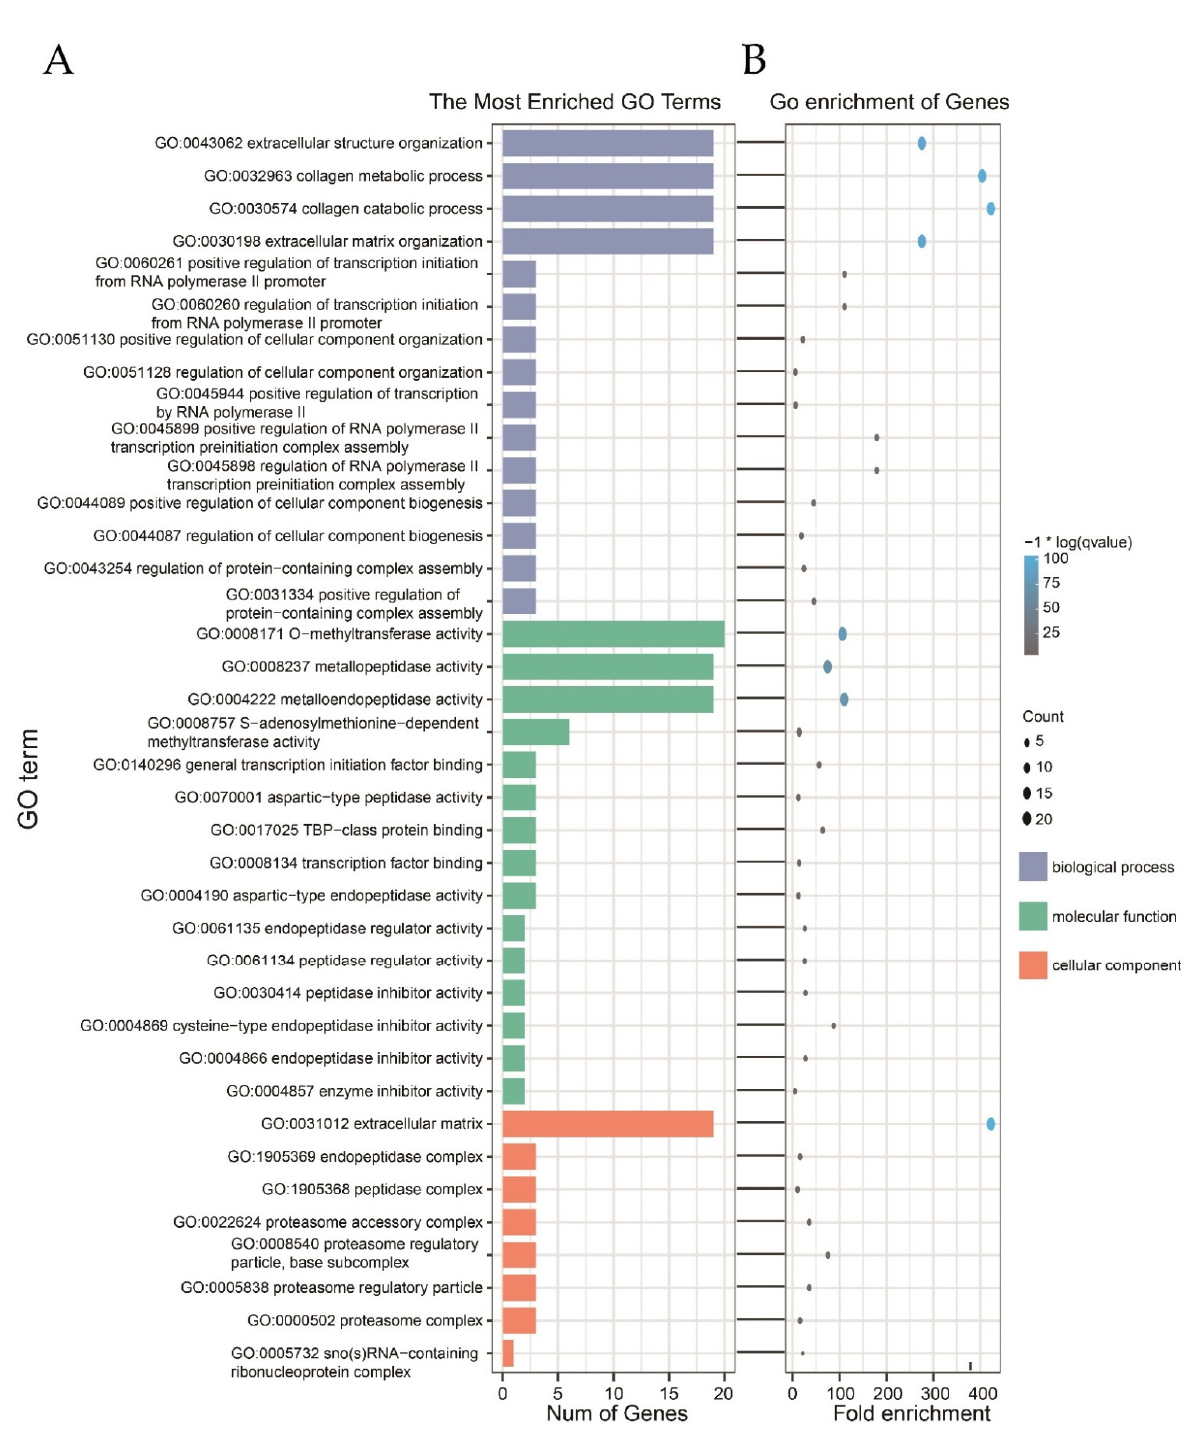
Figure 5. Histogram presentation of gene ontology (GO) annotation and enrichment of insect- defense response genes in Z. bungeanum . The results are summarized as three main categories: biological processes, cellular components, and molecular function. The x-axis represents the number of matched genes and the y-axis shows subgroups of molecular functions from the GO classification ( A ). Scatterplots of GO terms enriched in insect-defense response genes in Z. bungeanum (top 38). The size of the point represents the number of genes associated with the term in the related genes and colors represent q.adjust. Fold Enrichment is the ratio of the proportion of genes related to the term ( B ).